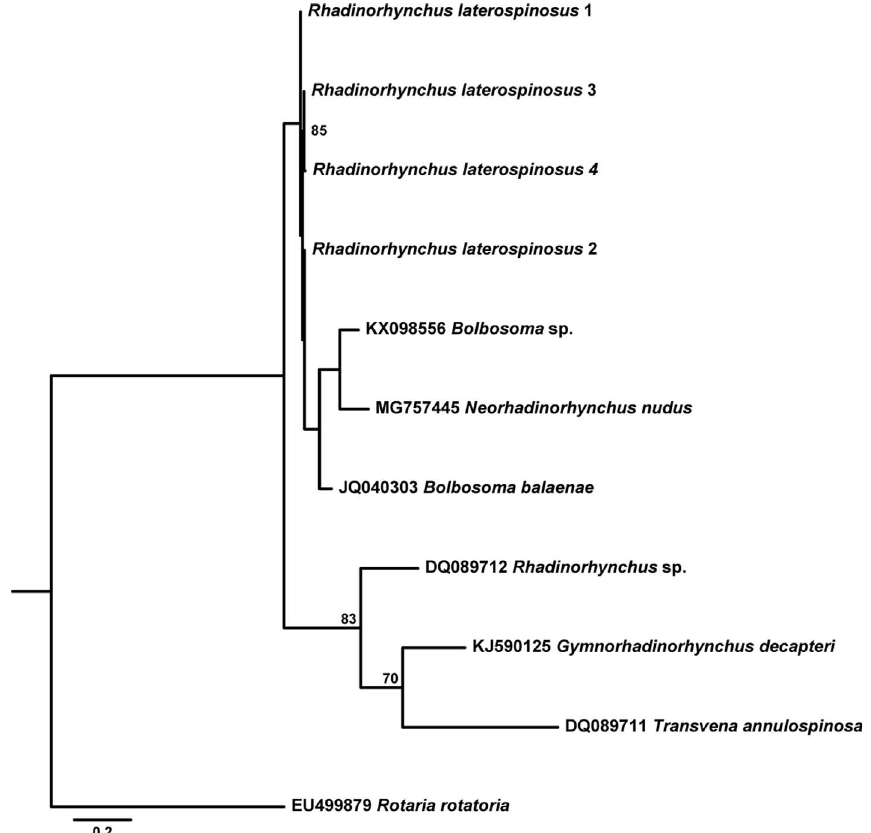
Figure 38. Maximum likelihood (ML) phylogram reconstructed using four newly generated cox 1 sequences for Rhadinorhynchus laterospinosus and retrieved sequences from GenBank for Rhadinorhynchus and the closest-related sequences to members of this genus. Outgroup: Rotaria rotatoria . Bootstrap values lower than 70 are omitted. The scale-bar indicates the expected number of substitutions per